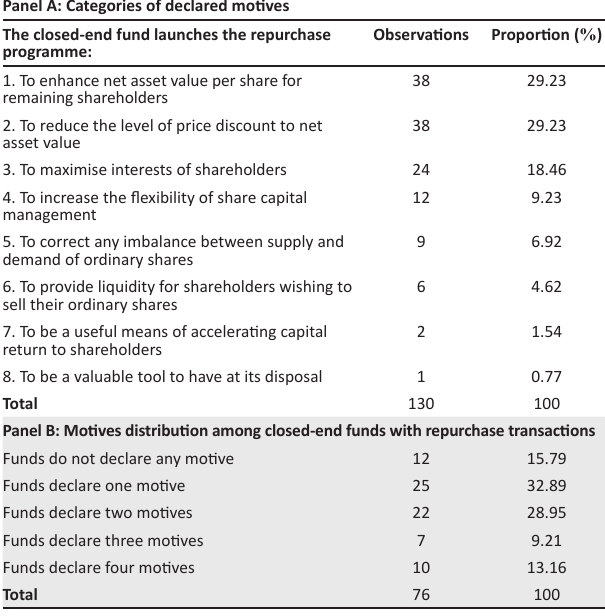
TABLE 1: Declared motives for open market repurchases of closed-end funds. Panel A: Categories of declared